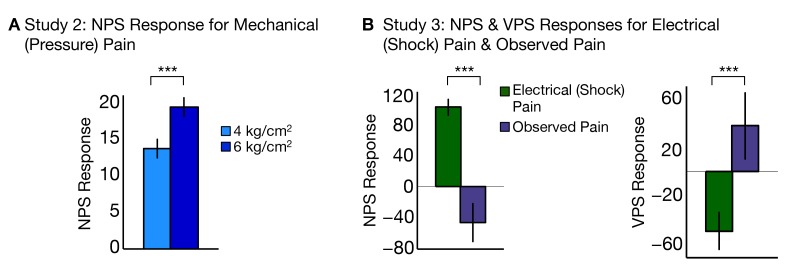
NPS and VPS responses for Study 2 and Study 3.(A) Study 2 – NPS responses for mechanical (pressure pain) delivered at low and high intensities, (i.e., 4 kg/cm2 and 6 kg/cm2) computed as the dot product of the NPS pattern weights and estimated activation maps for each participant (including within-participant standard error of the mean; total of five trials per level of stimulation per participant; (B) Study 3 – NPS (right) and VPS (left) responses for electrodermal (electrical or shock) pain and observed pain, computed as the dot product of the respective pattern weights for NPS (right) and VPS (left) and estimated activation maps for each participant (including within-participant standard error of the mean.